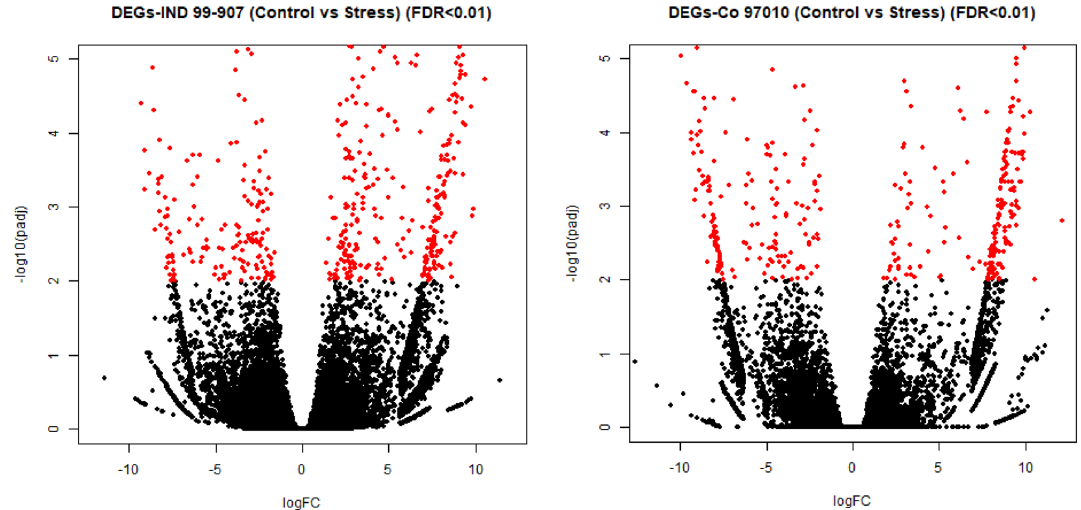
Figure 3. Volcano plots displaying the distribution of DEGs between control vs stress conditions of ( a ) IND99- 907 and ( b ) Co 97010 based on FDR <